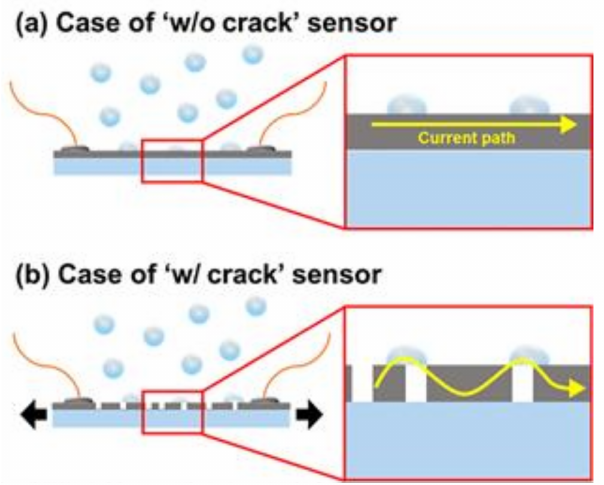
Figure 3. Schematic diagram of the electric current path for sensors ( a ) without (w/o) and ( b ) with (w/) crack sensors under high